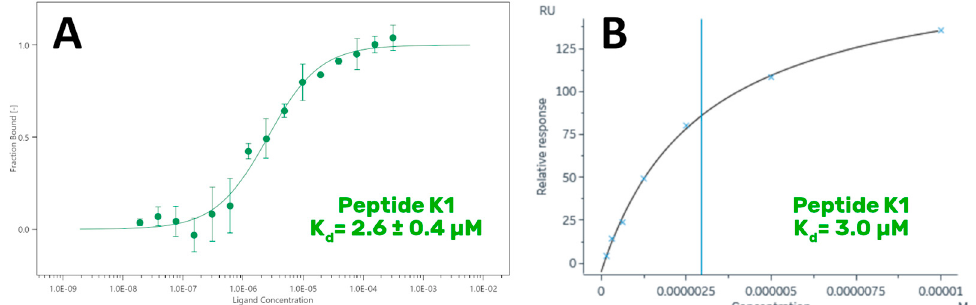
Figure 4. Binding of K1 peptide on GABARAP. MST curve ( A ) and steady-state analysis obtained by fitting the proper form of the Scatchard equation for the plot of the bound RU at equilibrium vs. the ligand concentration in solution during SPR experiments ( B ).